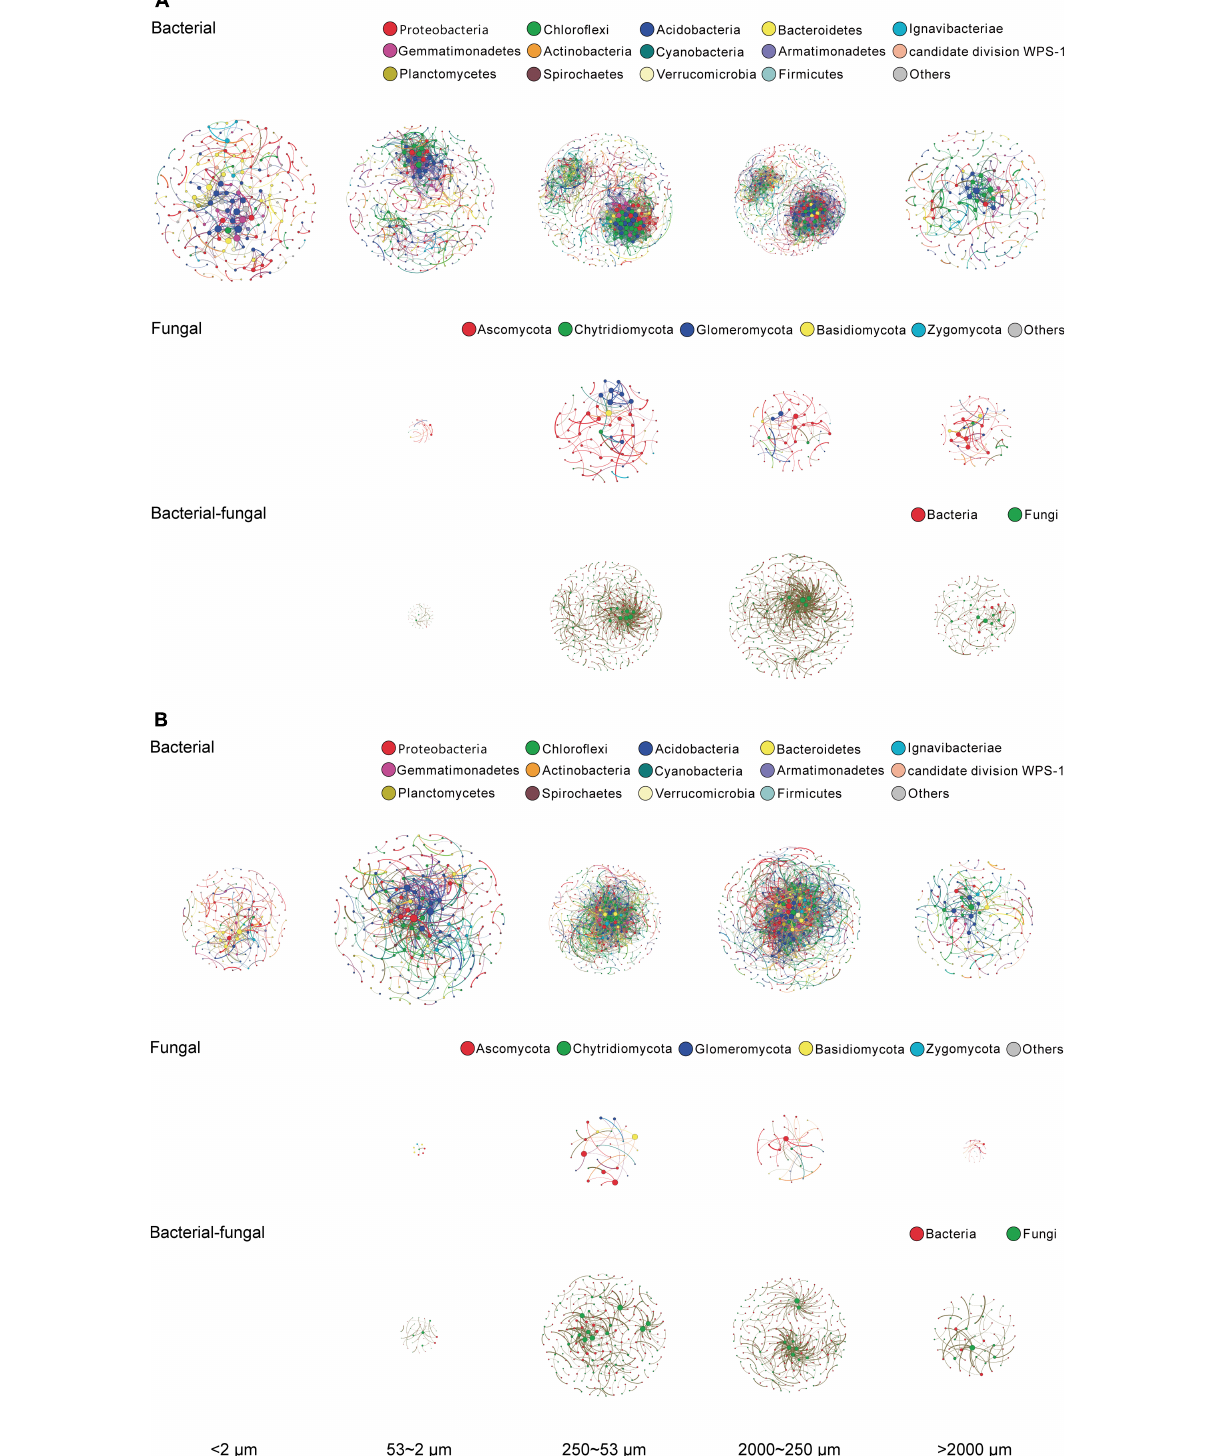
Frontiers in Microbiology |